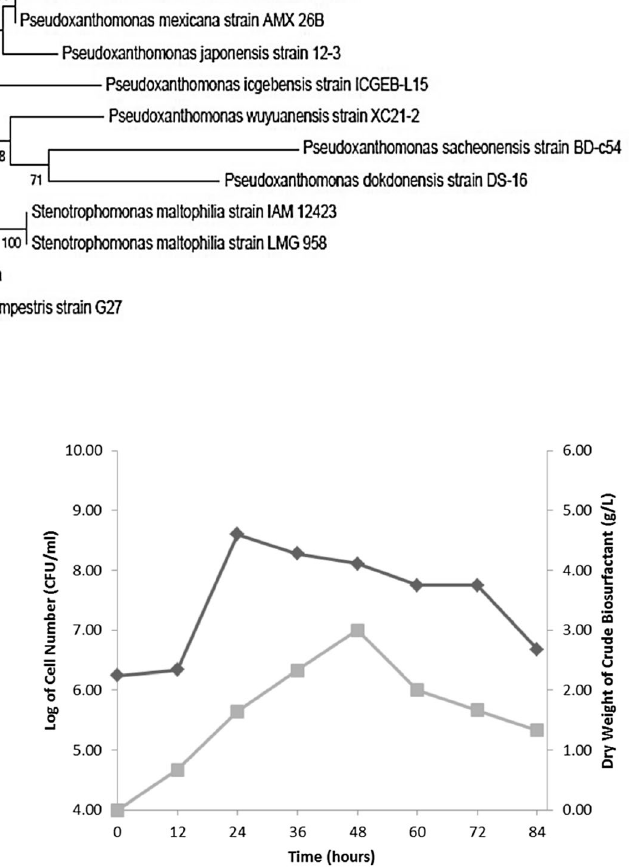
Fig. 2 Phylogenetic tree based on 16S rRNA sequencing analy- sis constructed by neighbor- joining method confirmed MEOR_G3 as a bacterium with Pseudoxanthomonas genus